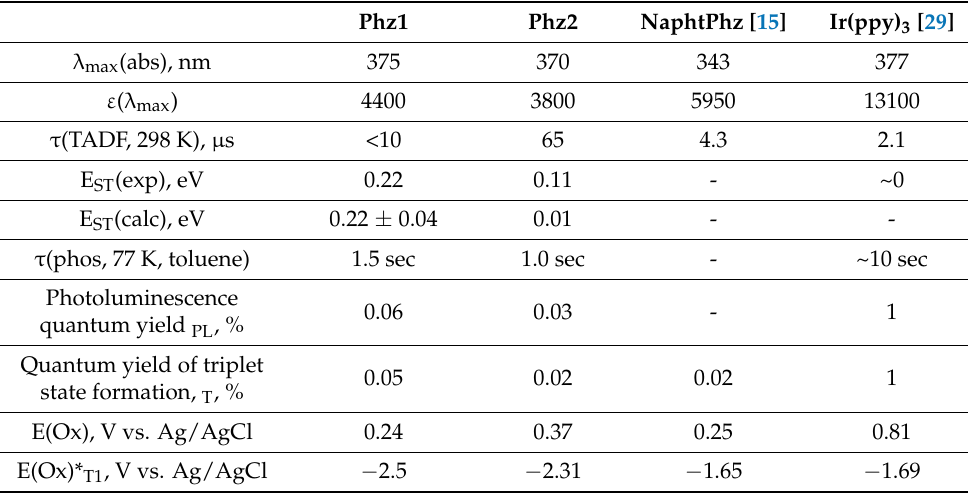
Table 1. Key parameters that determined the photoredox catalytic activity of Phz1 and Phz2 as well as those for the Ir(ppy) 3 complex and N , N ’ -dinaphtyldihydrophenazine (NaphtPhz).